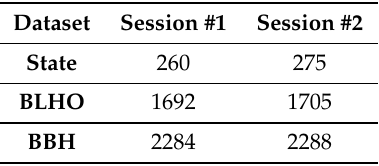
Table 3. Number of 5-second executions for each subset of the CogAge dataset. Executions of session #1 and #2 were respectively used to build the training and testing sets in the subject-dependent